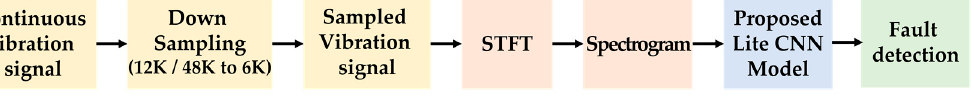
Figure 1. Bearing fault diagnosis process using the proposed lite CNN model.